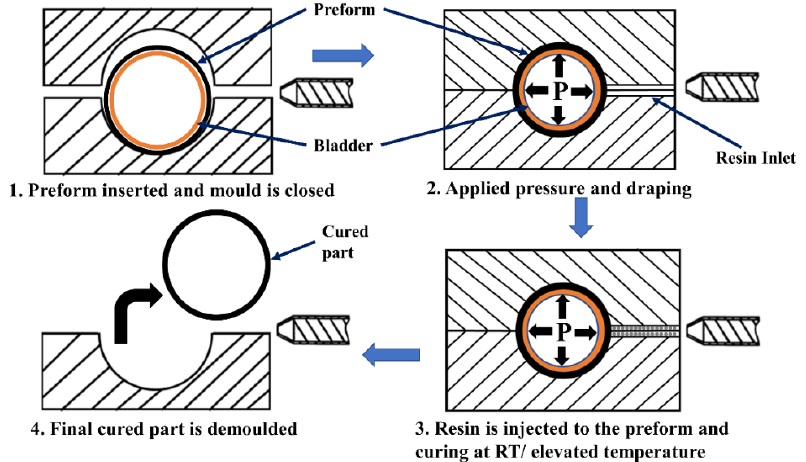
Figure 1. Schematic of the Bladder-assisted Resin Transfer Molding (B-RTM) process.